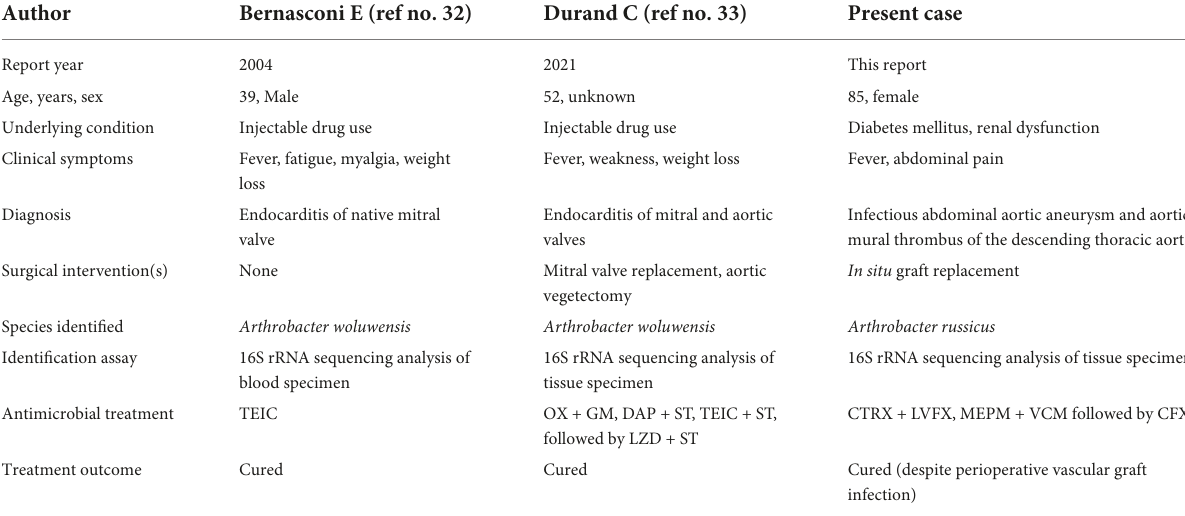
TABLE 1 Literature review of Arthrobacter -associated cardiovascular